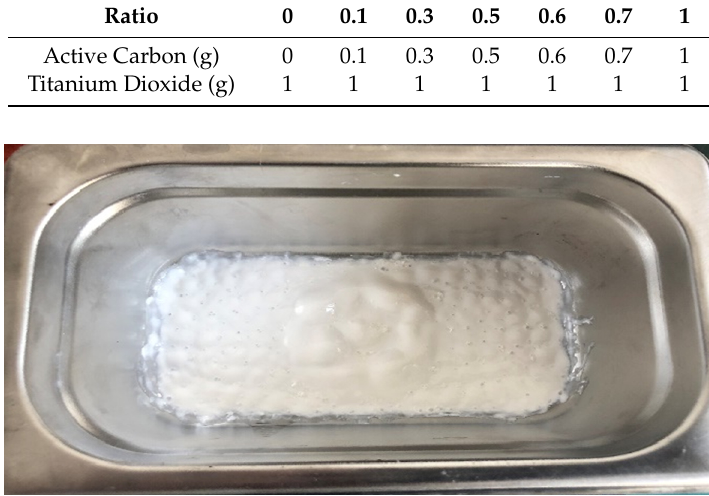
Figure 4. Ultrasonic vibration of titanium dioxide.